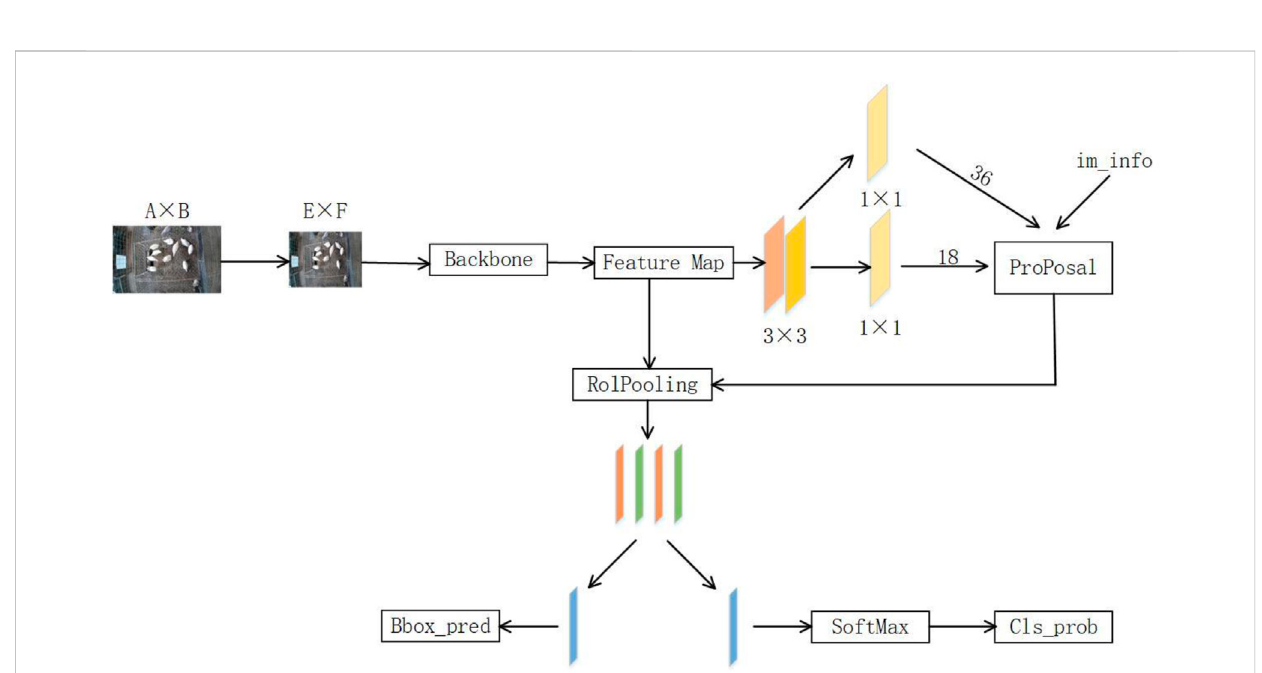
FIGURE 5 Faster-RCNN network